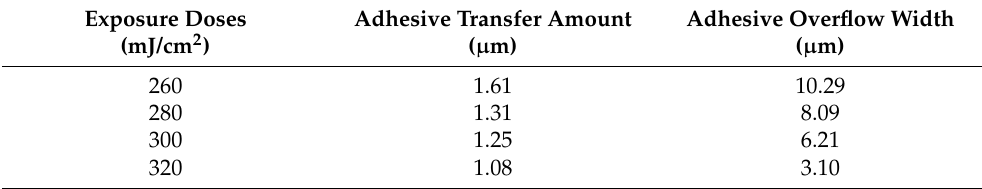
Table 3. The adhesive transfer amount and adhesive overflow width at different exposure doses.